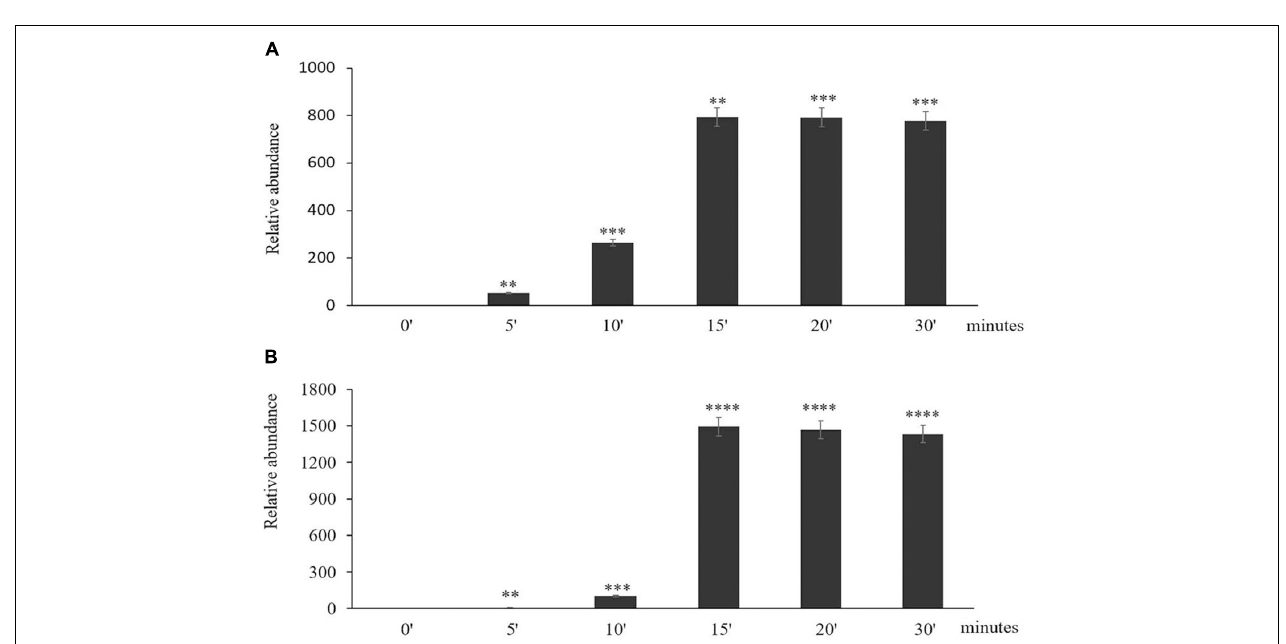
FIGURE 2 | The time course of expression of Heat Shock Protein ( HSP ) 101 (A) and Ascorbate Peroxidase ( APX ) 2 (B) in response to heat stress treatment. Asterisks indicate statistical significance ( P ≤ 0.05) between the treatments. Seedlings were exposed to heat stress for 0 (control), 5, 10, 15, 20, and 30 min. Values are means ± SD ( n = 3 independent biological replicates each consisting of 100 seedlings). Asterisks indicate significant differences between control and heat-stressed plants according to the Student’s t -test ( ∗ p < 0.05; ∗∗ p < 0.01; ∗∗∗ p < 0.001; and ∗∗∗∗ p < 0.0001).